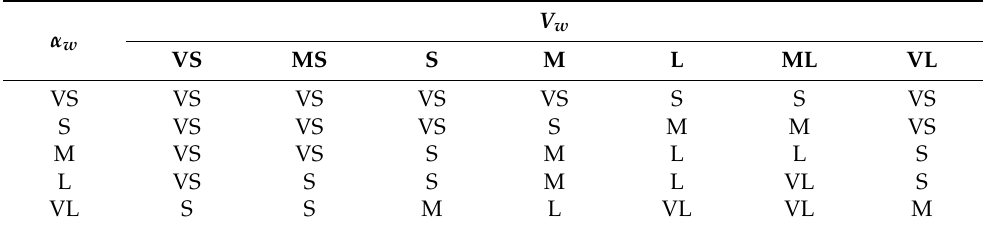
Table 2. The rules of FLC-2.